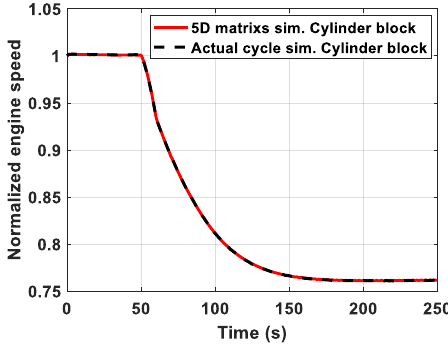
Figure 29. Engine speed time history.